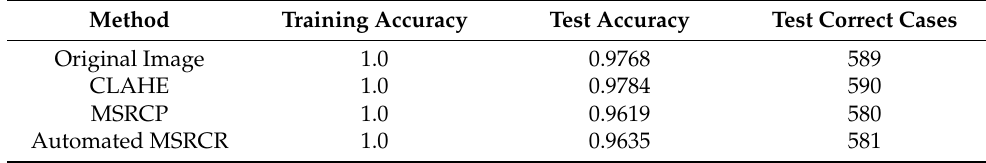
Table 5. Effects of image enhancement methods on WHU-RS19 dataset.